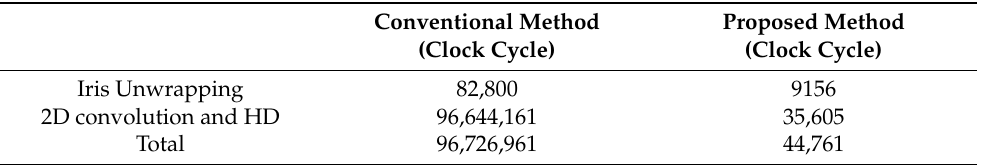
Table 4. Performance analysis of the conventional method and the proposed method for iris template creation and template